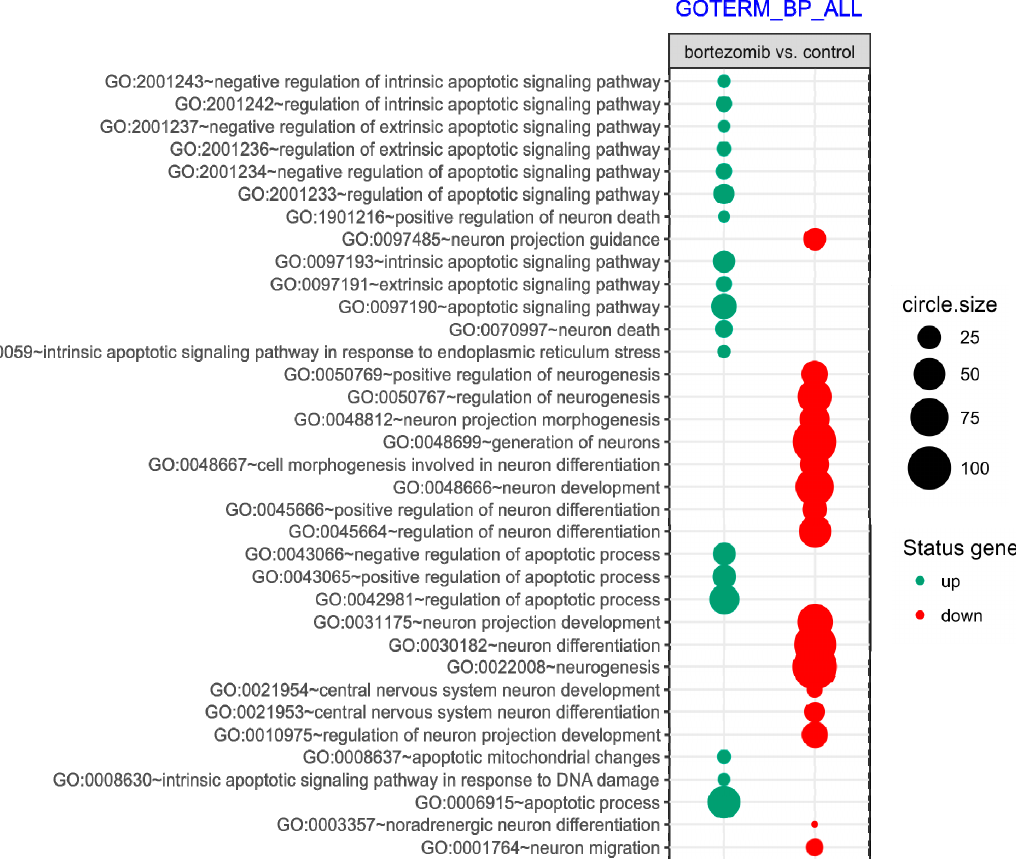
Figure 3 . The bubble plot of overrepresented biological processes involved in apoptosis and neurogenesis assigned according to gene ontology (GO) classification in bortezomib-treated SH-SY5Y cells compared to the control cells The groups of genes fulfilling criteria: Adjusted p < 0.05, method = Benjamini, and minimum number of genes per group = 5, are presented. Bubble size indicates the number of genes represented in corresponding annotation. The up- and downregulation is indicated by colors, with green corresponding to upregulation and red corresponding to downregulation.